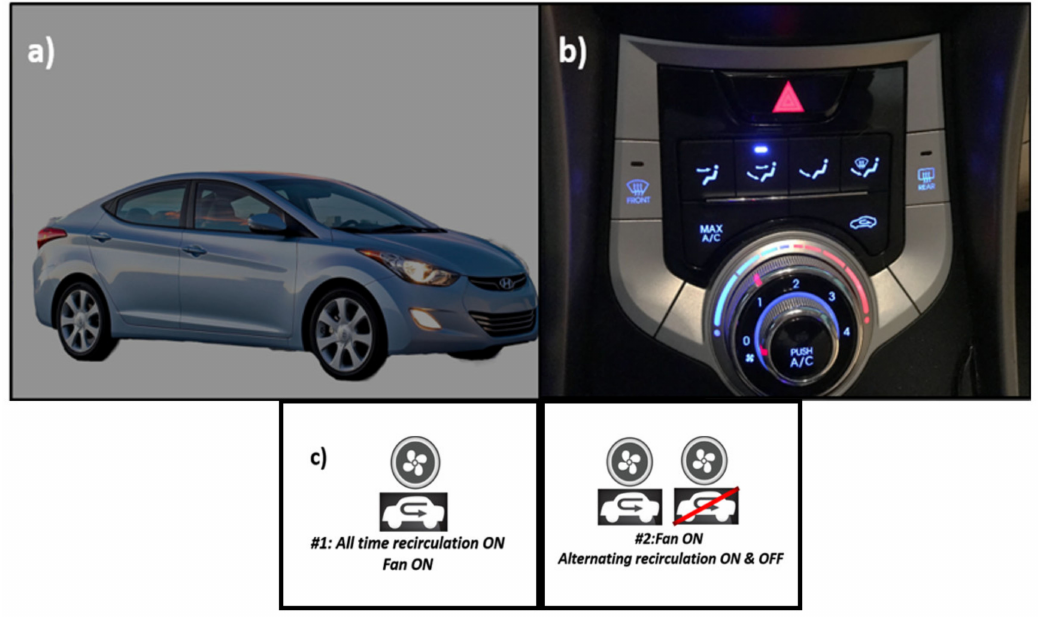
Figure 1. ( a ) Vehicle used in this study; ( b ) AC control panel; ( c ) Two di ff erent testing conditions, see text for